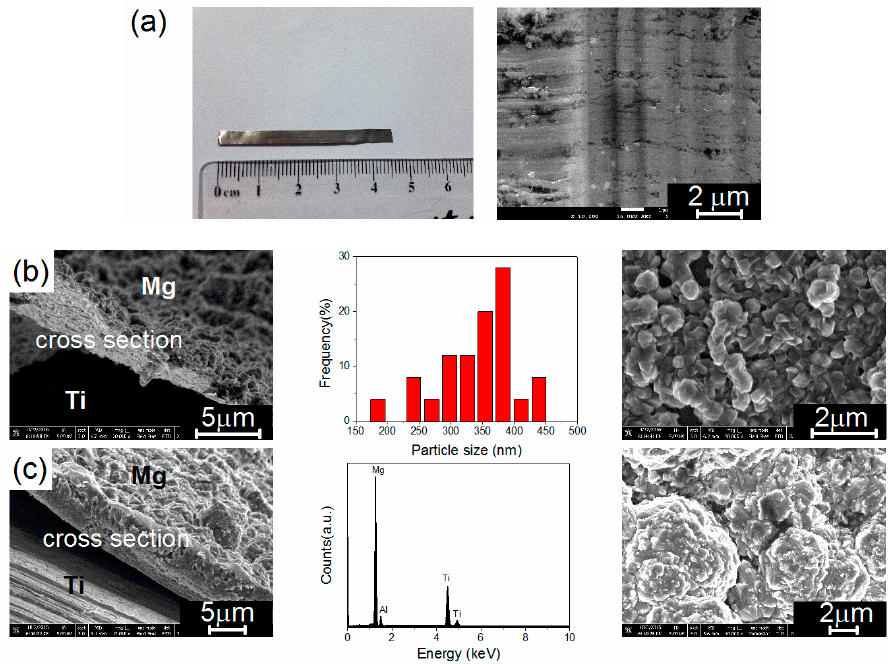
Figure 3. ( a ) Photo and typical SEM images of the pristine Ti foil; and typical SEM images and particle size distribution of the magnesium nanoparticles obtained at different deposition times ( b ) 1 h and ( c ) 15 h of di- n -butylmagnesium at the Ti surface.